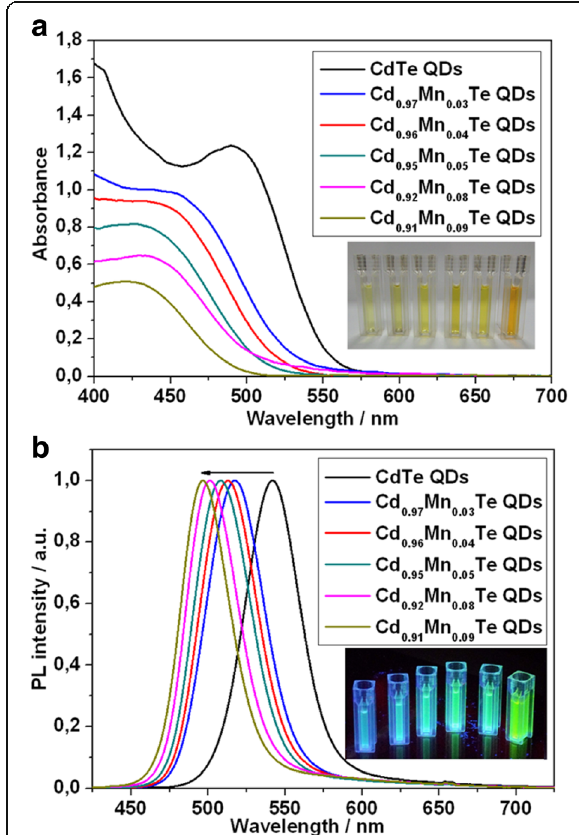
Fig. 2 Absorption ( a ) spectra of CdTe and series of Cd 1-x Mn x Te-alloyed QDs with different content of Mn 2+ ions. Inset: the images of CdTe and series of Cd 1-x Mn x Te-alloyed QDs under daylight-lamp light. Normalized PL ( b ) spectra of CdTe and series of Cd 1-x Mn x Te-alloyed QDs with different content of Mn 2+ ions. Inset: the images of CdTe and series of Cd 1-x Mn x Te QDs under UV